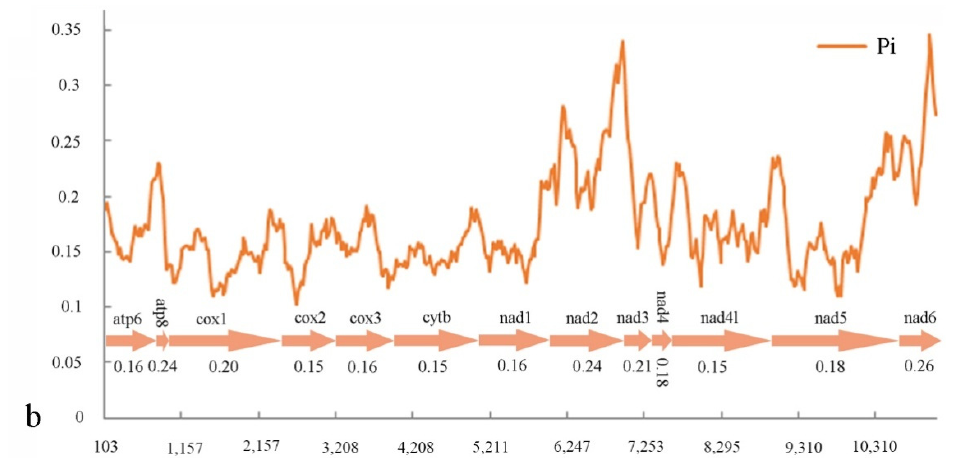
Figure 5. ( a ) Ka/Ks ratios and genetic distances; ( b ) nucleotide diversity of PCGs of Cleridae. The polyline represents the value of nucleotide diversity (a sliding window of 200 bp with the step size of 20 bp), and the average value for each gene is shown under the gene